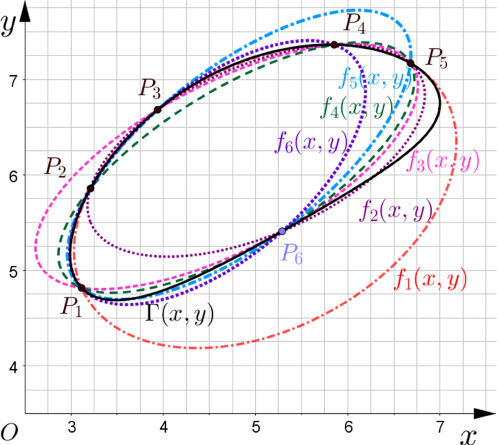
Figure 1. Geometric schematic of the conic filtering algorithm. (cid:48) ( x,y ) have highly similar curve properties within a cer- tain range (or a large neighborhood). For example, the conic curve f 1 ( x,y ) within the range of ( P 1 – P 5 ) has a smaller error than the coupler curve, while the conic curve f 4 ( x,y ) within the range of ( P 1 , P 2 , P 4 – P 6 ) has a larger error than the cou- pler curve, though their shapes are similar.